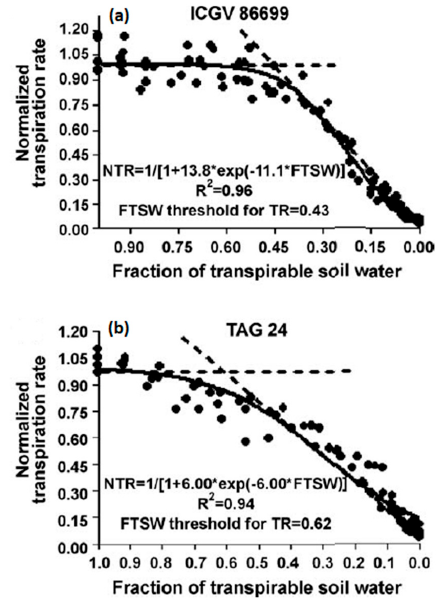
Figure 1. Graph of normalized transpiration rate relative to the transpiration rate of well-watered plants for each genotype plotted against fraction of transpirable soil water for 6 week old peanut plants grown on mineral soil in 2.4 L pots [32]. These plants were subjected to controlled soil drying over about 2 weeks. The normalized was done to allow convenient comparison between genotypes ICGV 8699 ( a ) and TAG 24 ( b